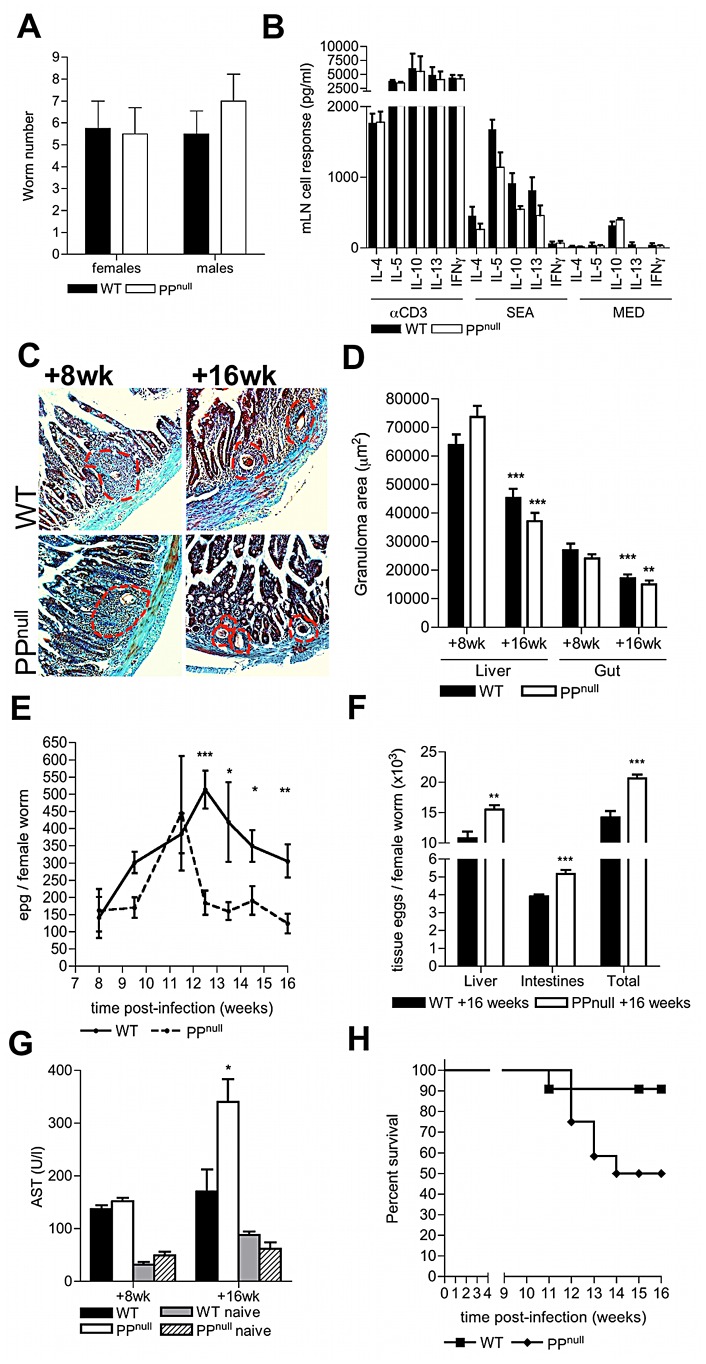
PP are required to sustain optimum egg transmission and limit host morbidity.(A) Quantitative analysis of adult schistosome worm recoveries following perfusion of the hepatic portal system in WT or PPnull mice. (B) Cytokine secretion by mLN cells from WT and PPnull mice 8 weeks post-infection following in vitro stimulation with anti-CD3 mAb, or soluble egg antigen. (C) Masson's Trichrome stained histological sections of duodenum (blue = collagen) at post-infection in WT or PPnull mice (red dotted lines = extent of egg granulomas). (D) Reduction in granuloma areas at 16 cf. 8 weeks; min 4 granulomas/mouse, **P<0.01, ***P<0.001, unpaired T test: nd = no difference between WT and PPnull. (E) Numbers of faecal eggs from WT and PPnull mice 8–16 weeks pi, and (F) tissue eggs in the small intestine and liver at week 16; both normalised to female worm burden. (G) Levels of AST enzyme in the serum of naïve or infected mice. (H) Incidence of morbidity of ‘moderate severity’; P = 0.0507, survival analysis. Statistical analysis is for PPnull versus WT mice, *P<0.05, **P<0.01, ***P<0.001, unpaired T test of log10-transformed data (E) or raw data (D, F, G & H). Data is mean+SEM of two independent experiments, (A, B & D; n = 4), or combined data of two independent experiments (E–H; n = 7–13).